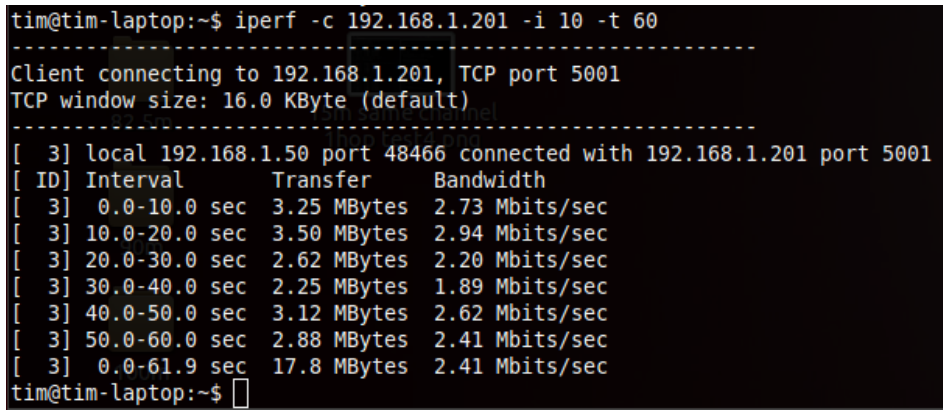
Figure 11. Sample bandwidth results for the stations that were connected to the WMN through a different channel with the backhaul